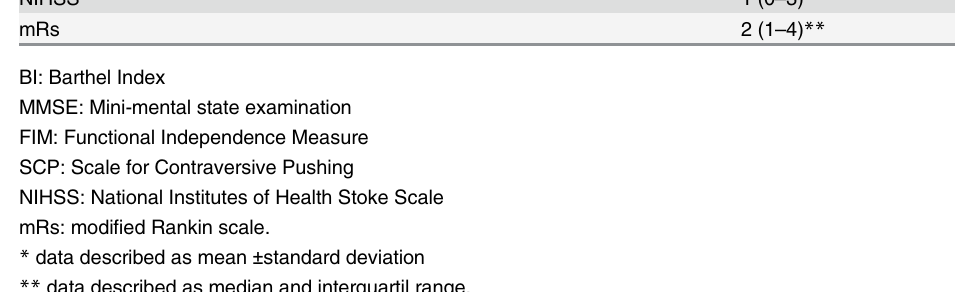
34.4 ± 9.9 days. The demographic and clinical characteristics of all participants are listed in Table 1. The median SPV in the roll plane was 0.34° (interquartile range: -1.44° to 2.54°) and in the pitch plane was 0.36° (interquartile range: -2.72° to 2.45°). The median HV in the roll plane was -0.94° (interquartile range: -5.86° to 3.84°) and in the pitch plane was 3.56° (interquartile range:-0.68° to 8.36°). Table 2 shows the results of posturographic assessments in sitting and upright positions. All patients completed the posturografic assessments in the sitting position, while in the